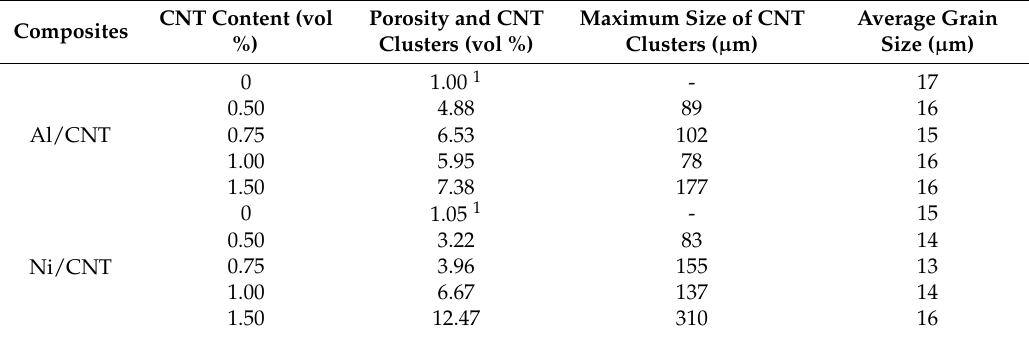
Table 1. Maximum size of CNT clusters, percentage of porosity and CNT clusters and average grain size as a function of the CNT content.